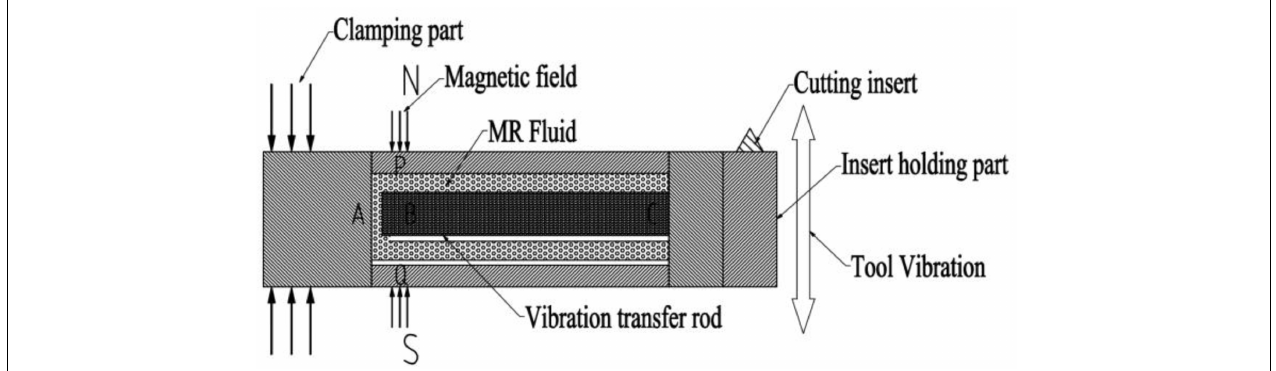
FIGURE 4 | Schematic diagram of boring bar construction (Biju and Shunmugam, 2019).